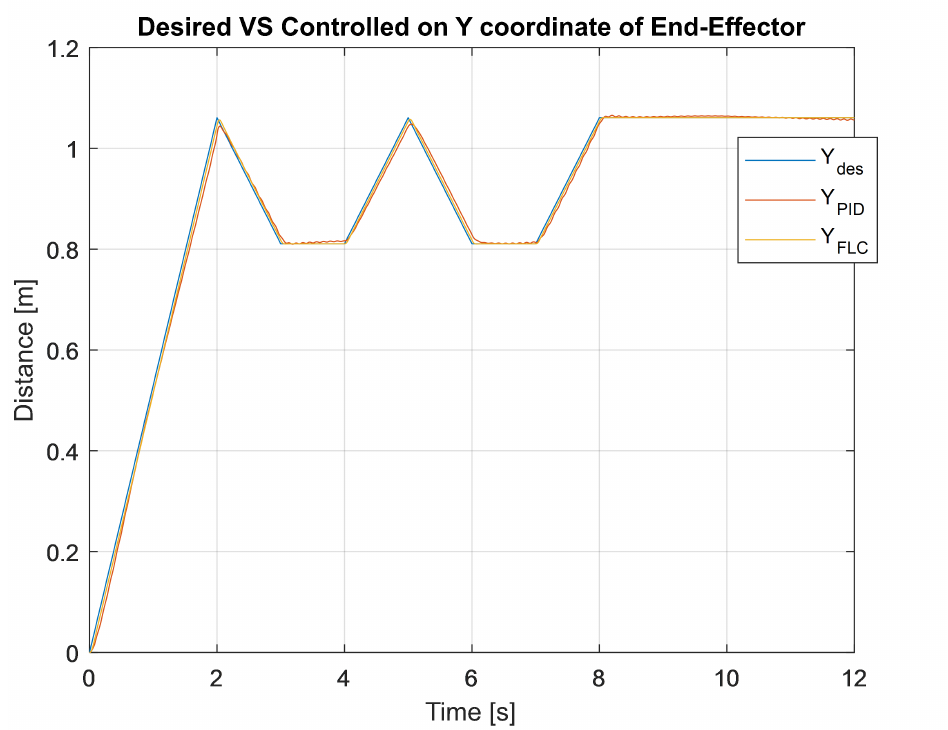
Figure 11. Trajectory tracking result for Y component of end-effector position.